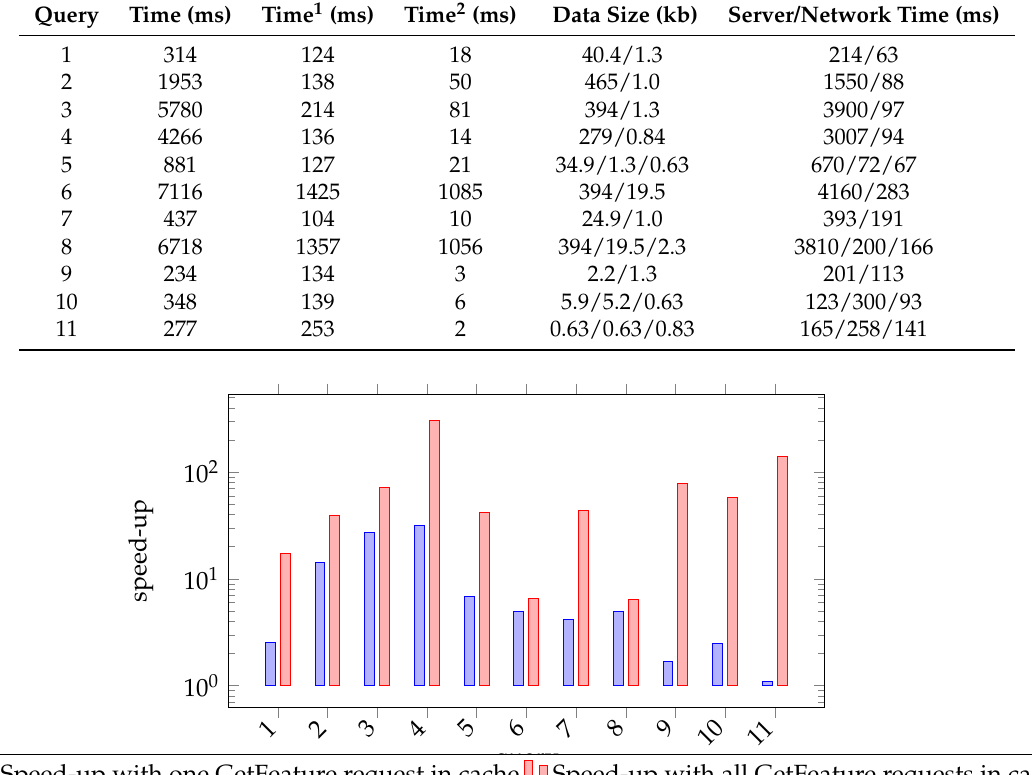
Figure 7. Speed-up (log-scale) of query response time via